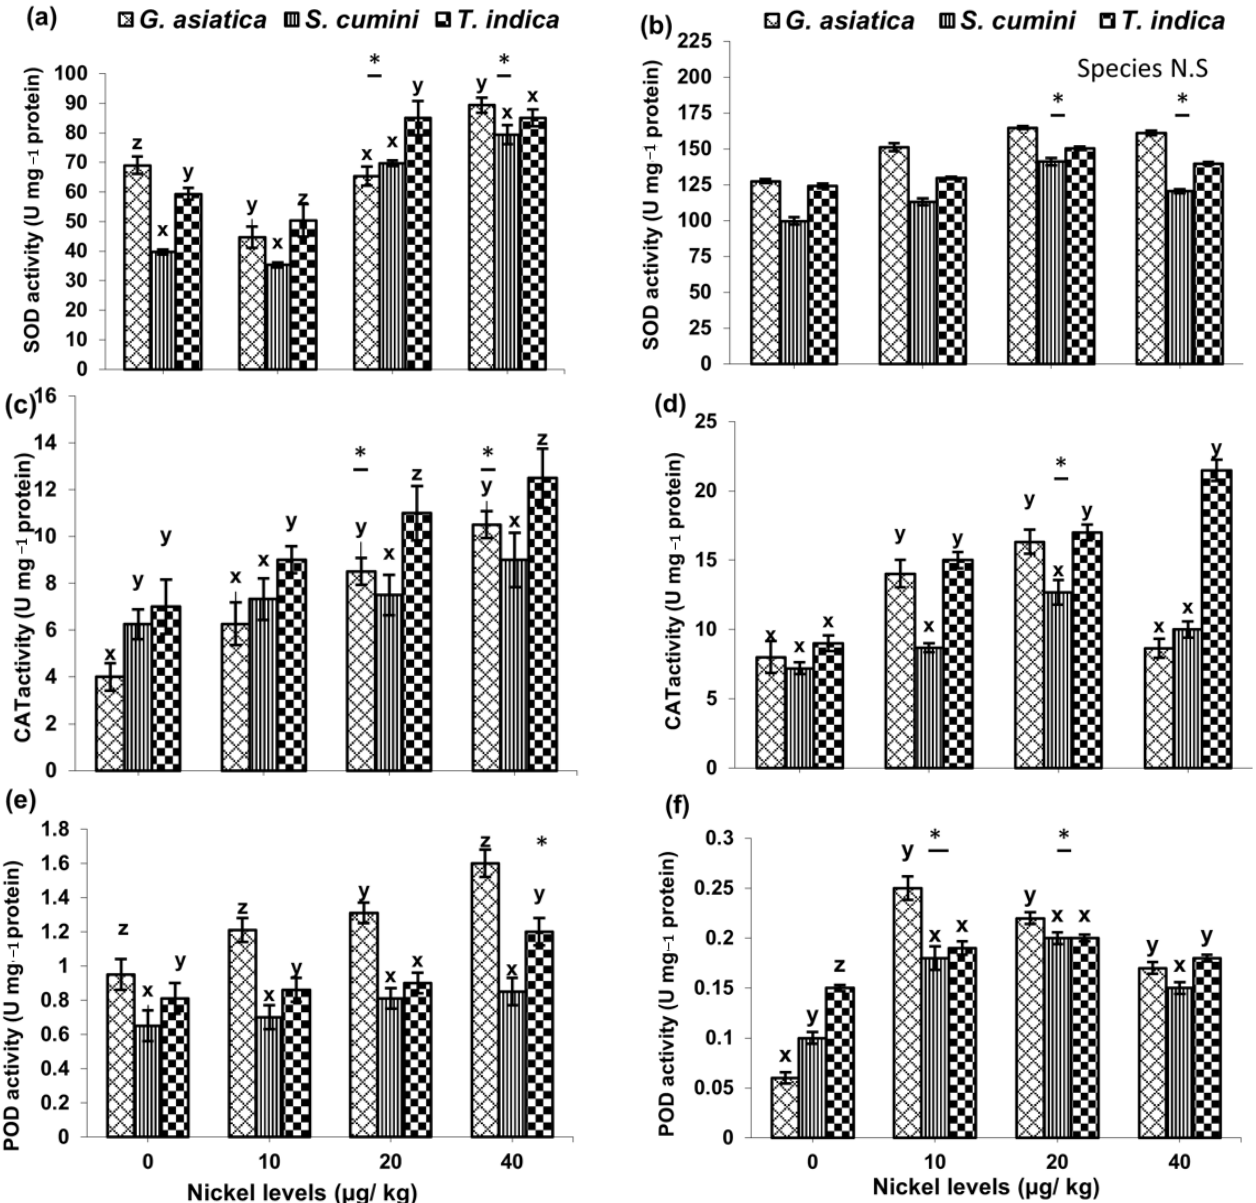
Figure 4. Activity of antioxidant enzymes SOD ( a , b ) CAT ( c , d ) and POD ( e , f ) in leaves and roots of three minor fruit species ( Grewia asiatica L ., Syzgium cumini (L.) Skeels and Tamarindus indica L.) after exposure to increasing levels of Ni in the growth medium. Each mean is across three replicates with ± S.E. Different letters on each bar indicate significant difference between species (x – z) and * on each level shows a marked variability from the control analyzed through two-factor ANOVA, with equal number of replications, followed by a post hoc multiple comparison test (DMRT).